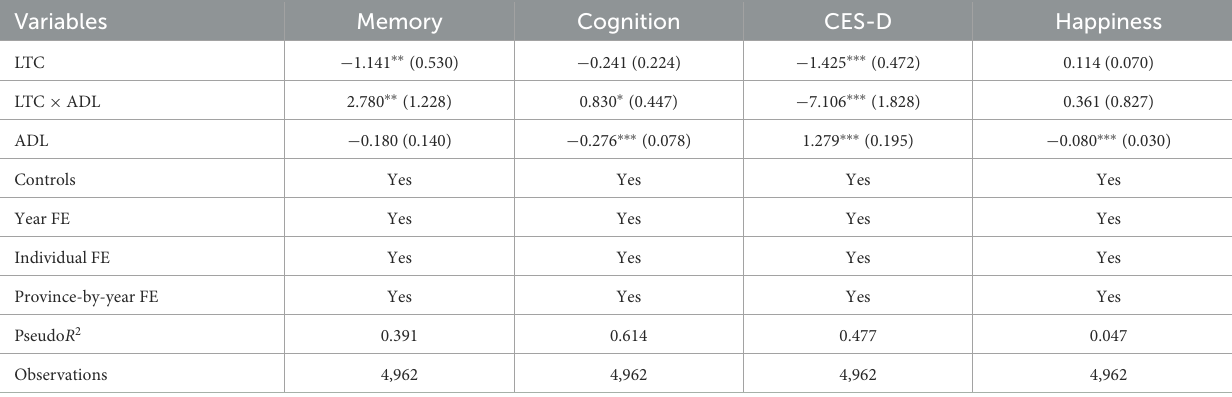
TABLE 6 The effects on the mental health, by difficulties in